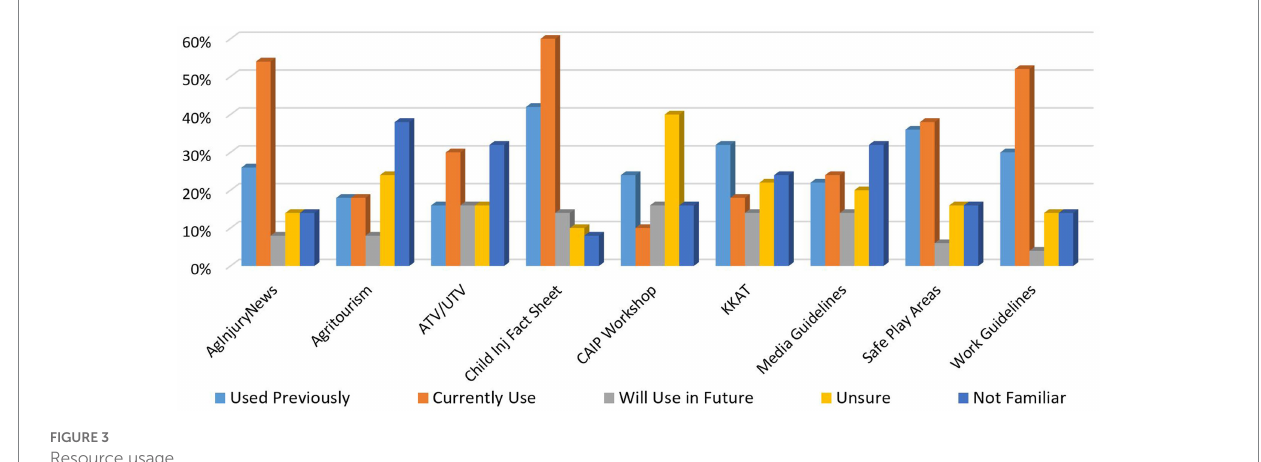
FIGURE 3 Resource usage.